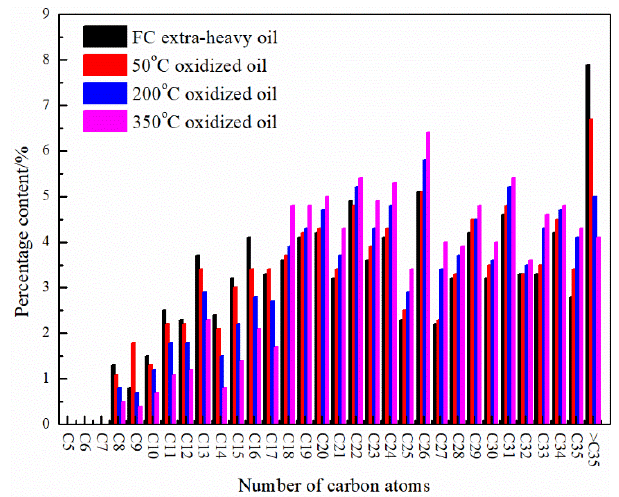
Figure 5. Carbon hydrocarbon distribution of FC extra-heavy oil and oxidized oils.